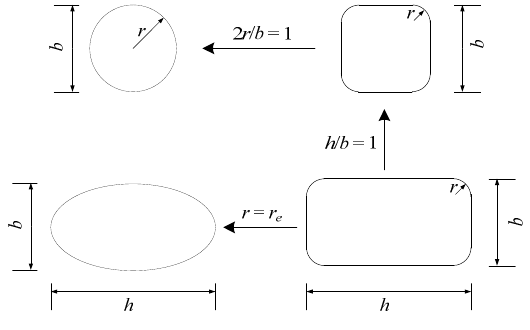
Figure 7. Elliptical cases. ( a ) h ≈ b ; ( b ) h >> b .